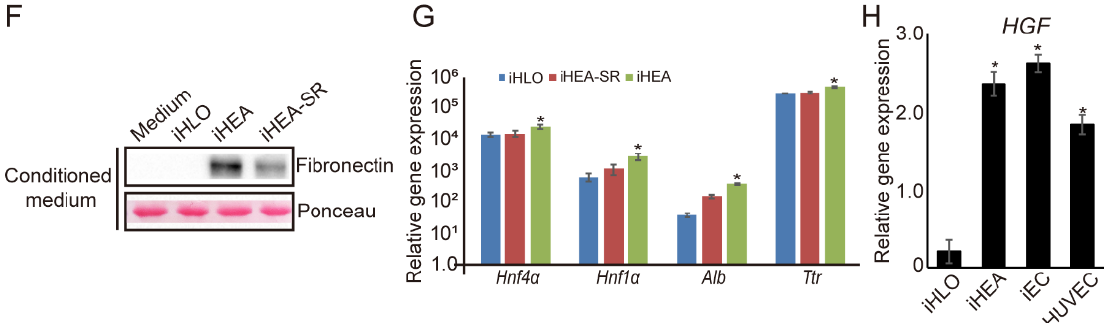
Figure 3. Gene expression of cell–ECM and cell–cell signaling-related genes, as well as hepatic-specification genes associated with FN1 expression of iHLOs and iHEAs. ( A ) Immunofluorescence images of iHLOs and iHEAs stained with FN1, Alb and vWF. The cells were counterstained with DAPI. Scale bar: 50 µ m. White arrows indicate FN1-stained area. ( B ) qPCR analysis of FN1 expression in iHLOs and iHEAs relative to HF1. The transcriptional levels were normalized to the housekeeping gene ( GAPDH ). Error bars indicate standard errors from triplicate samples ( n = 3). ( C ) qPCR analysis of cell–ECM signaling-related gene ( ItgαV and Itgβ1 ) ( D ) and cell–cell signaling-related gene ( Ocln , Cdh1 and Cdh2 ) expression in iHLOs and iHEAs relative to MEFs. The transcriptional levels were normalized to the housekeeping gene ( Gapdh ). Error bars indicate standard errors from triplicate